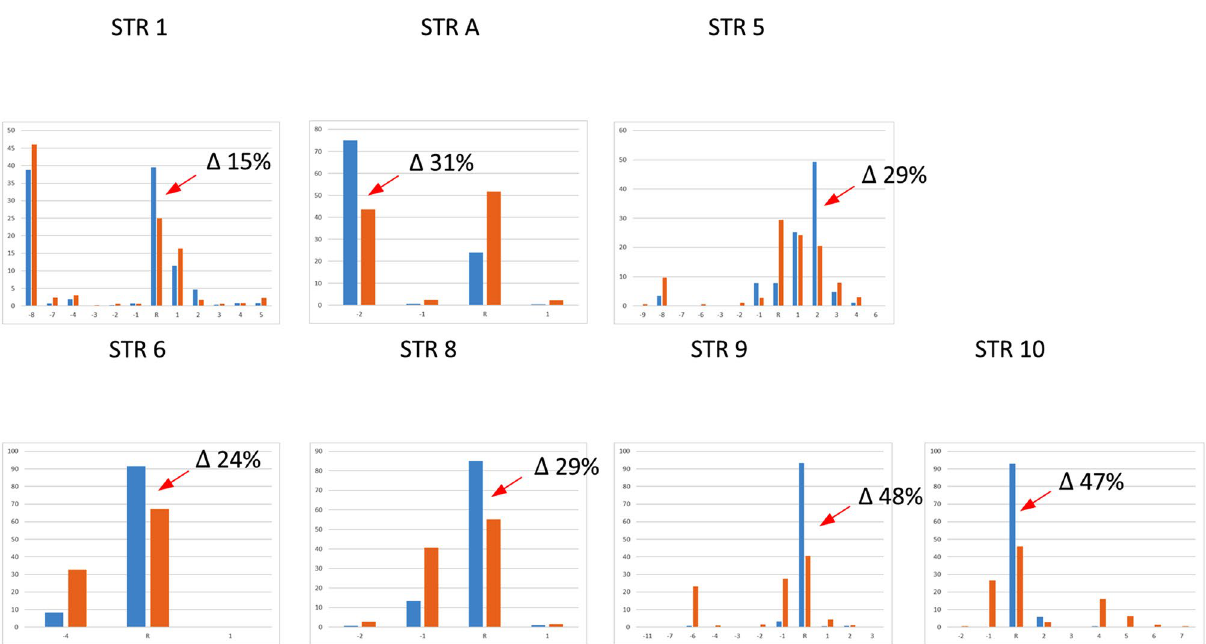
Figure 3. Allele frequency distributions of nine STR markers estimated for predicted brown eye (n = 62) color Europeans (brown bar) and predicted blue eye (n = 42) color Europeans (blue bar). Red arrows indicate the alleles with increased frequency in blue eye color predicted individuals (differences in frequency are indicated by Δ n%).